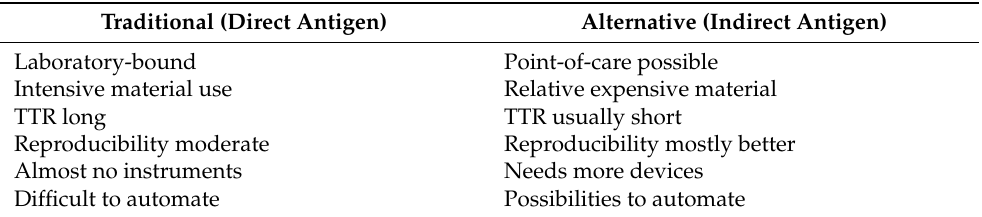
Table 6. Comparison of characteristics of direct and indirect antigen methods ( cf . Table 4). The table only lists those items which differ